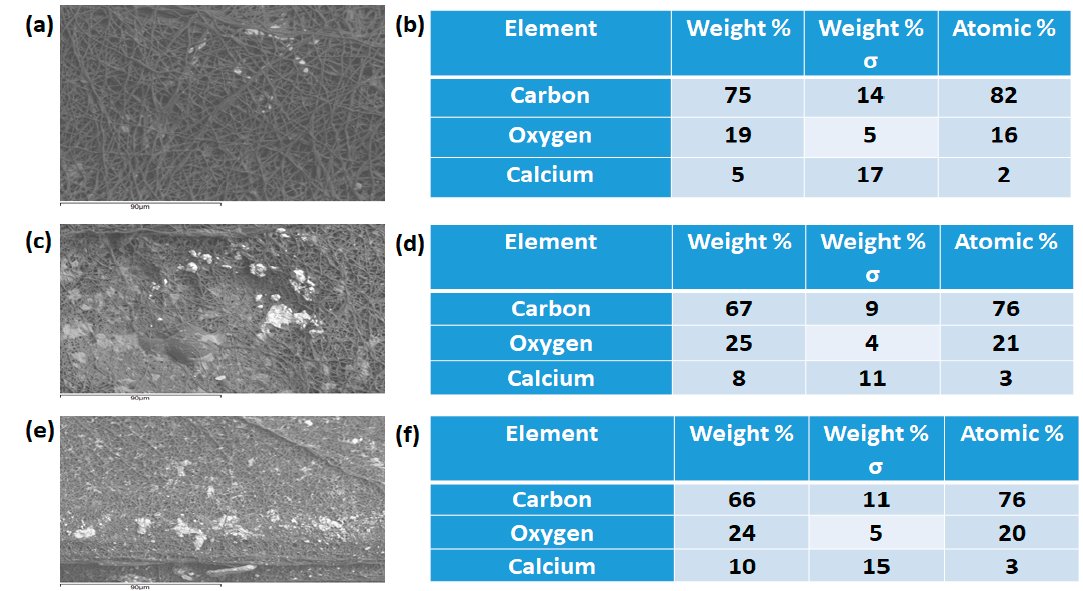
Figure 12. Scanning electron microscopy (SEM) and Energy Dispersive X-Ray Spectroscopy (EDX) of calcium deposition of ( a , b ) PU, ( c , d ) PU/YY and ( e , f ) PU/YY/ZnNO 3.